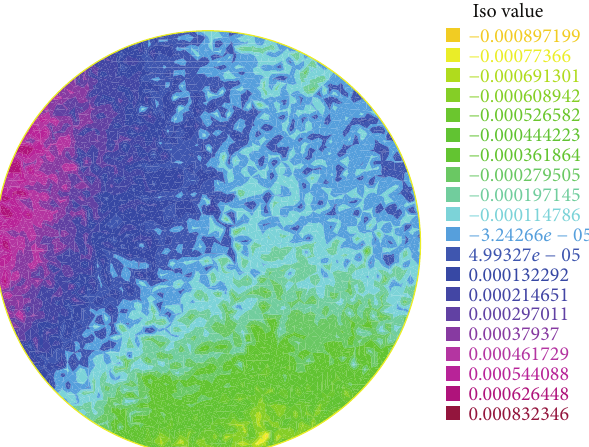
Figure 3: The difference between the exact and the numerical